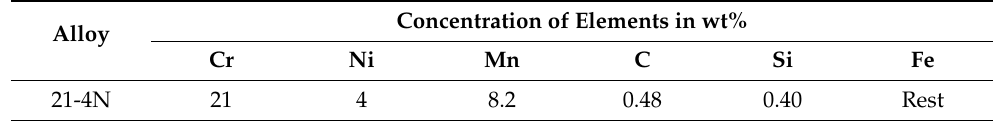
Table 1. Individual elemental composition for 21-4N steel.